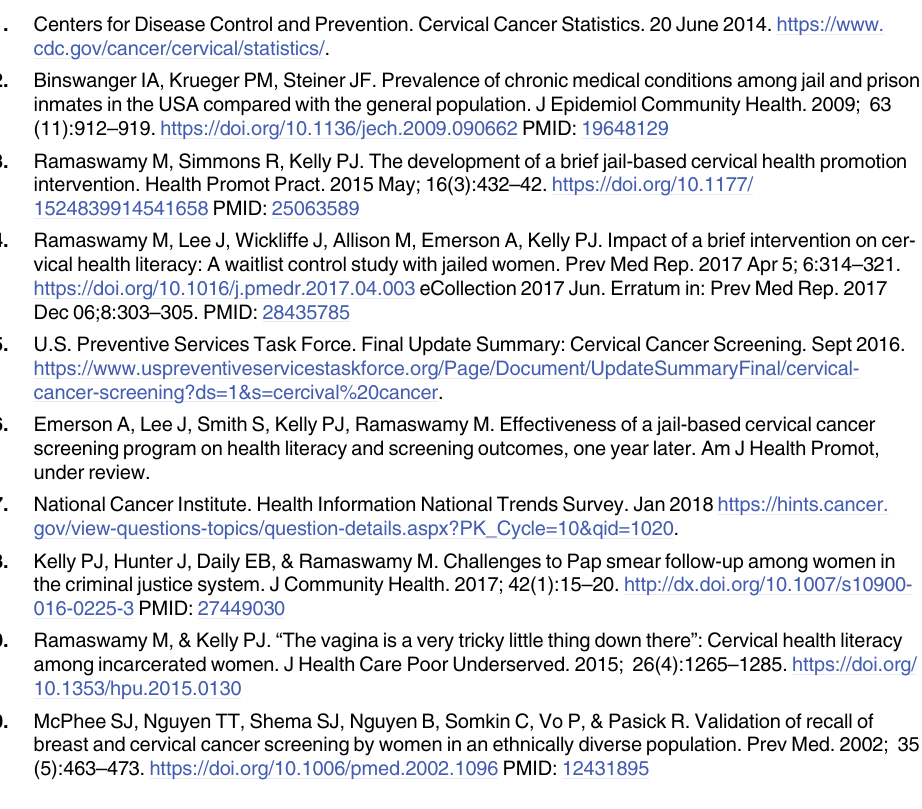
S1 Fig. Flow chart for selection of study